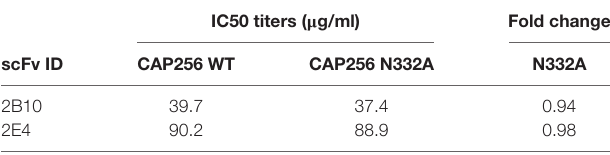
TaBle 3 | Assessment of N332 V3-glycan dependent neutralization activity of 2B10 and 2E4